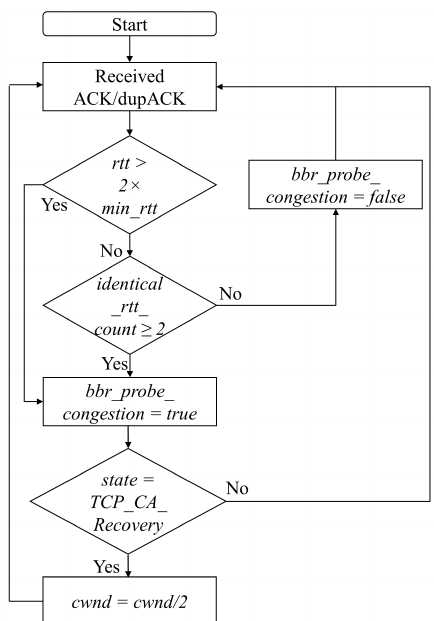
Figure 8. Flow chart of the key advanced congestion detection and CWND halving mechanism of BBR with advanced congestion detection